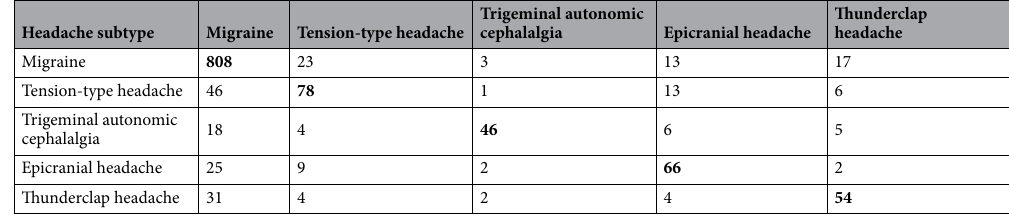
Table 4. Confusion matrix for the training cohort. The bold numbers in the main diagonal denote correctly classified subjects.